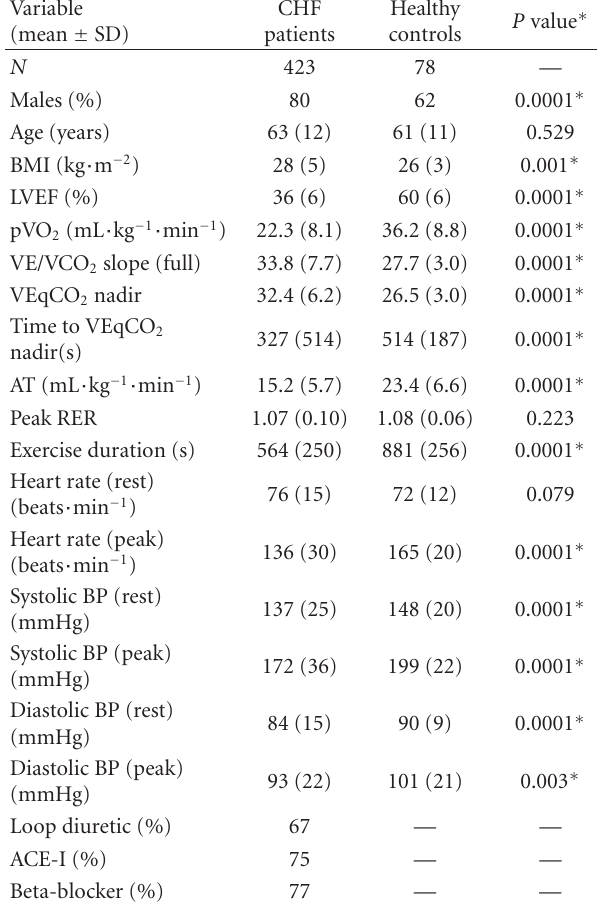
Table 1: Baseline clinical characteristics between CHF patients and healthy controls.